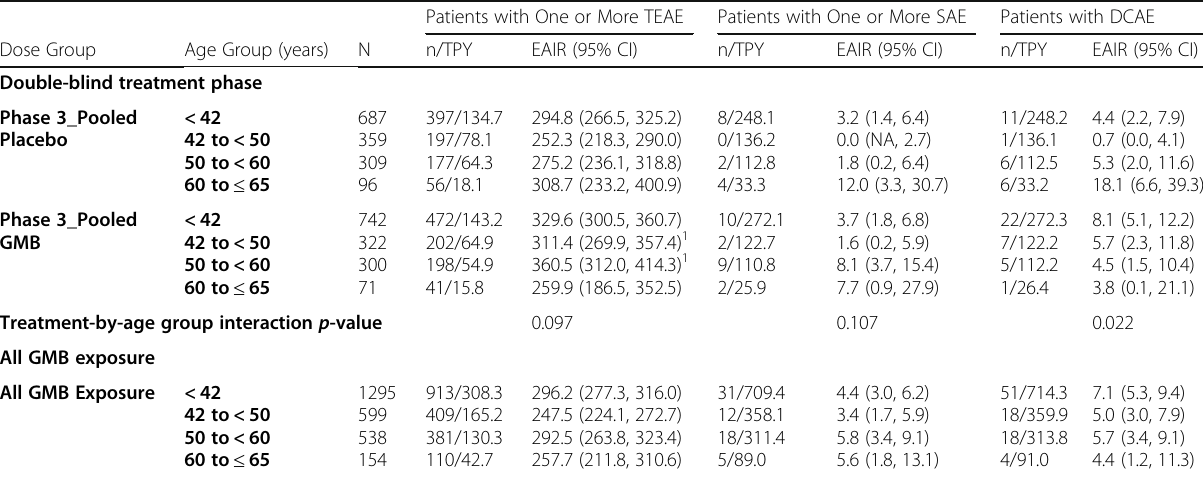
Abbreviations : All GMB Exposure, patients treated with any GMB dose in any duration, CI Confidence interval, DCAE Discontinuation due to adverse event, EAIR Exposure-adjusted incidence rate, GMB Galcanezumab, Phase 3_Pooled all patients from the 3 placebo-controlled phase 3 trials, SAE Serious adverse event, TEAE Treatment-emergent adverse event, TPY Total patient years at risk 1 p ≤ 0.05 compared with